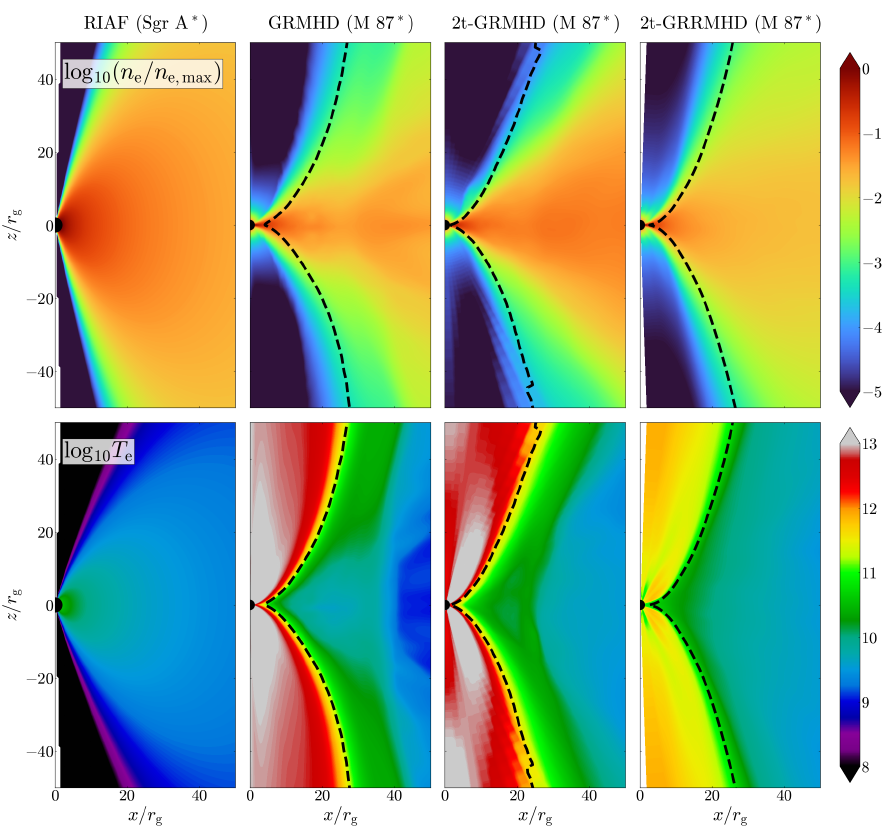
Figure 6. We show t- and ϕ -averaged data: electron number density n e (top row) and temperature T e (bottom row). We also denote the jet boundary with σ = 1 (black lines). The time-averaging is performed over the 5000 r g / c for each model. RIAF plots are for Sgr A ∗ while the rest are for M87. The Sgr A ∗ GRMHD model produces similar plots of n e and T e as the M87 ∗ model, and, hence, we do not show it